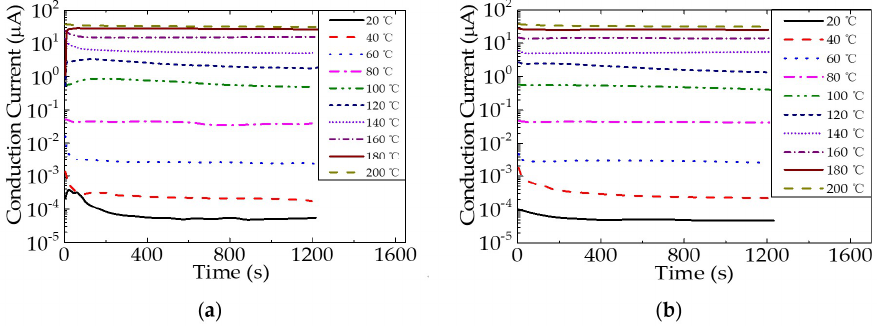
Figure 7. Conduction current of epoxy resin ( a ) and epoxy/nano − SiO 2 /micro − BN composite ( b ) as a function of time.